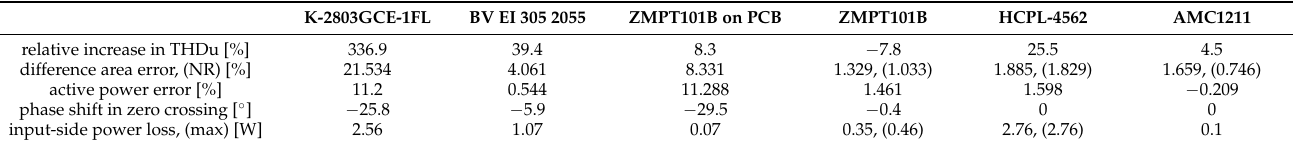
Table 6. Summary of the calculated errors and the energy consumption of the input parts of the circuits. Difference area error values in parentheses correspond to the output signal corrected by the floating average calculation according to Formula (7). The input power loss values in parentheses correspond to the maximum adjustable input